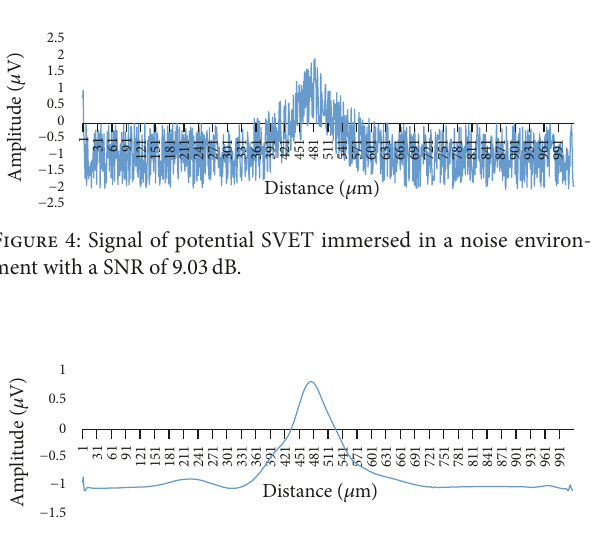
Figure 5: Electrical noise attenuation with Wavelet Denoise with SNR of 178.56 dB.